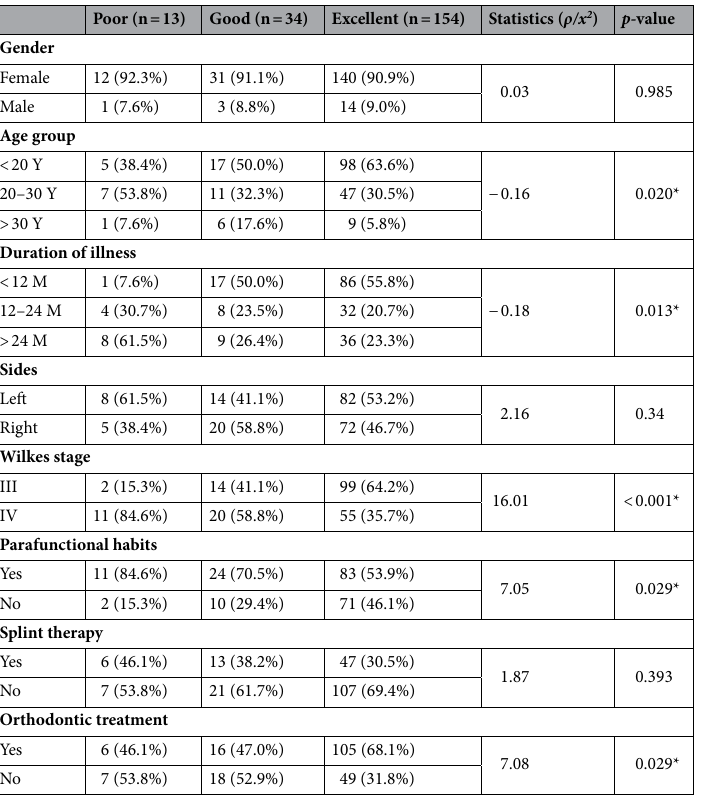
Table 2. Demographics and clinicopathologic characteristics of patients based on their surgical outcomes. Univariate analysis of the influence of patient-specific prognostic factors. x 2 -Chi-square test (for binary variable including gender, side and Wilkes stage). ρ -Spearman regression test (to analyze the two ordered multiple categorical variable: age group and duration of illness). n number of joints, Y years, M months. *Statistically significant.